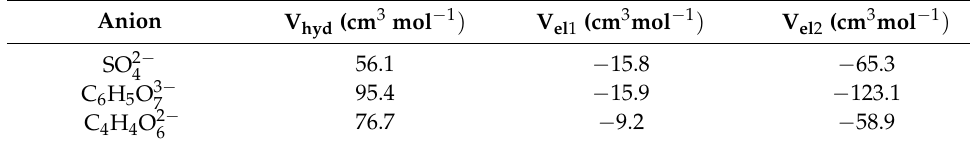
Table 2. Volume of hydration anion (V hyd ), volume of electrostriction on hydration shell (V el1 ), and volume of water shell around itself (V el2